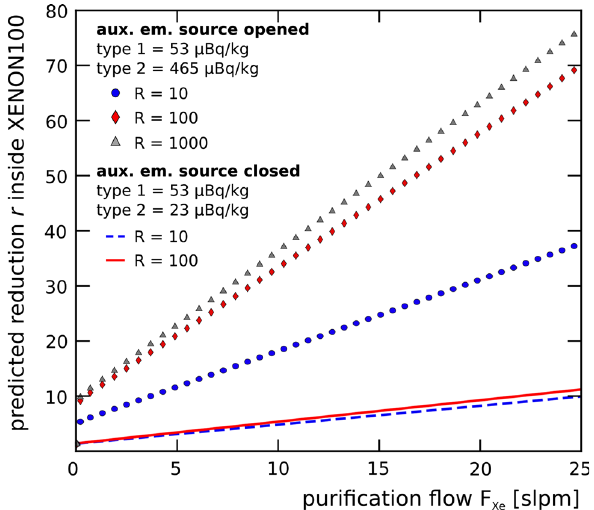
Fig. 7 Expected 222 Rn reduction r (Eq. (7)) inside the XENON100 detector as a function of the purification flow F Xe . We distinguish between the scenarios having the auxiliary emanation source opened (type 2 dominated emanation) and having it closed (type 1 dominated emanation). The reduction r is predicted for different reduction factors R for the radon removal